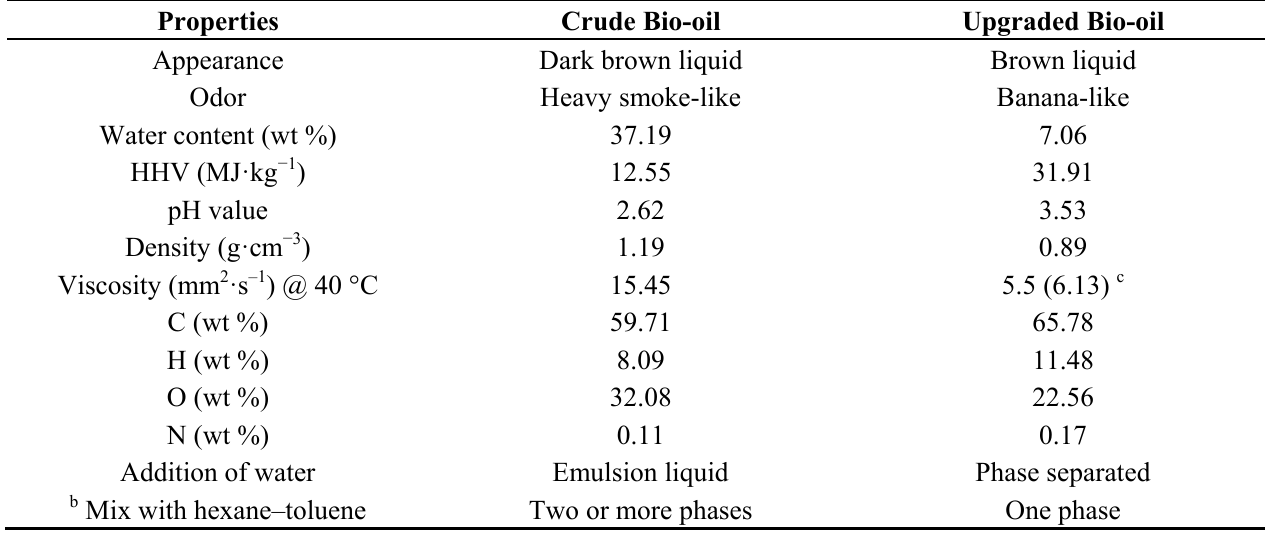
Table 5. Fuel properties of crude bio-oil and bio-oil upgraded with 1-octene/1-butanol over SSA for 3 h a